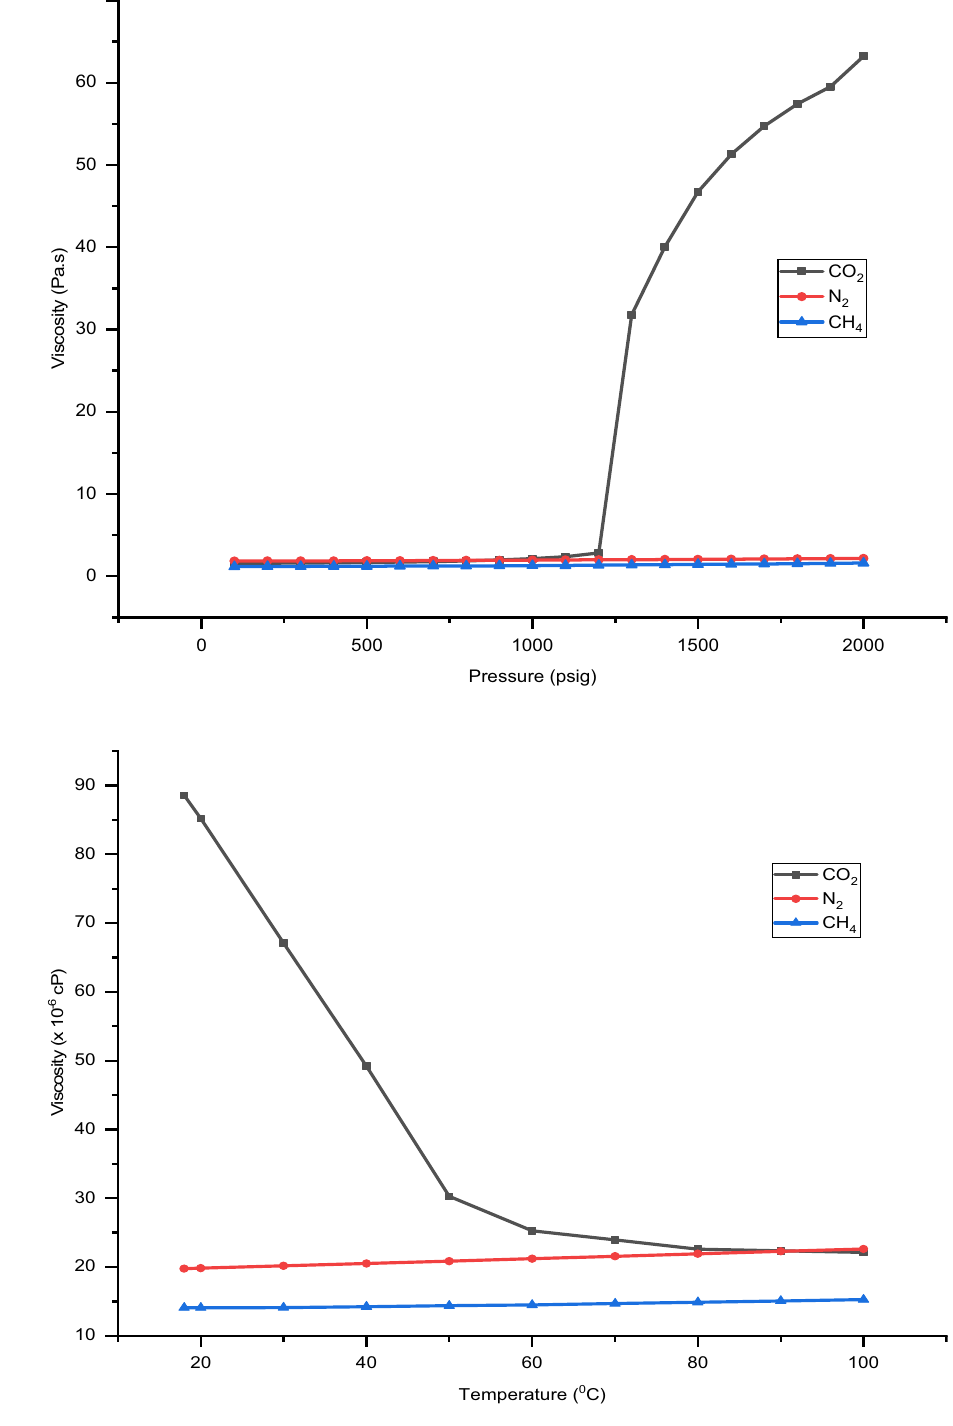
Fig. 3 CH 4 , N 2 and CO 2 viscosity as a function of pres- sure at 40 °C (generated from FLUIDATR)